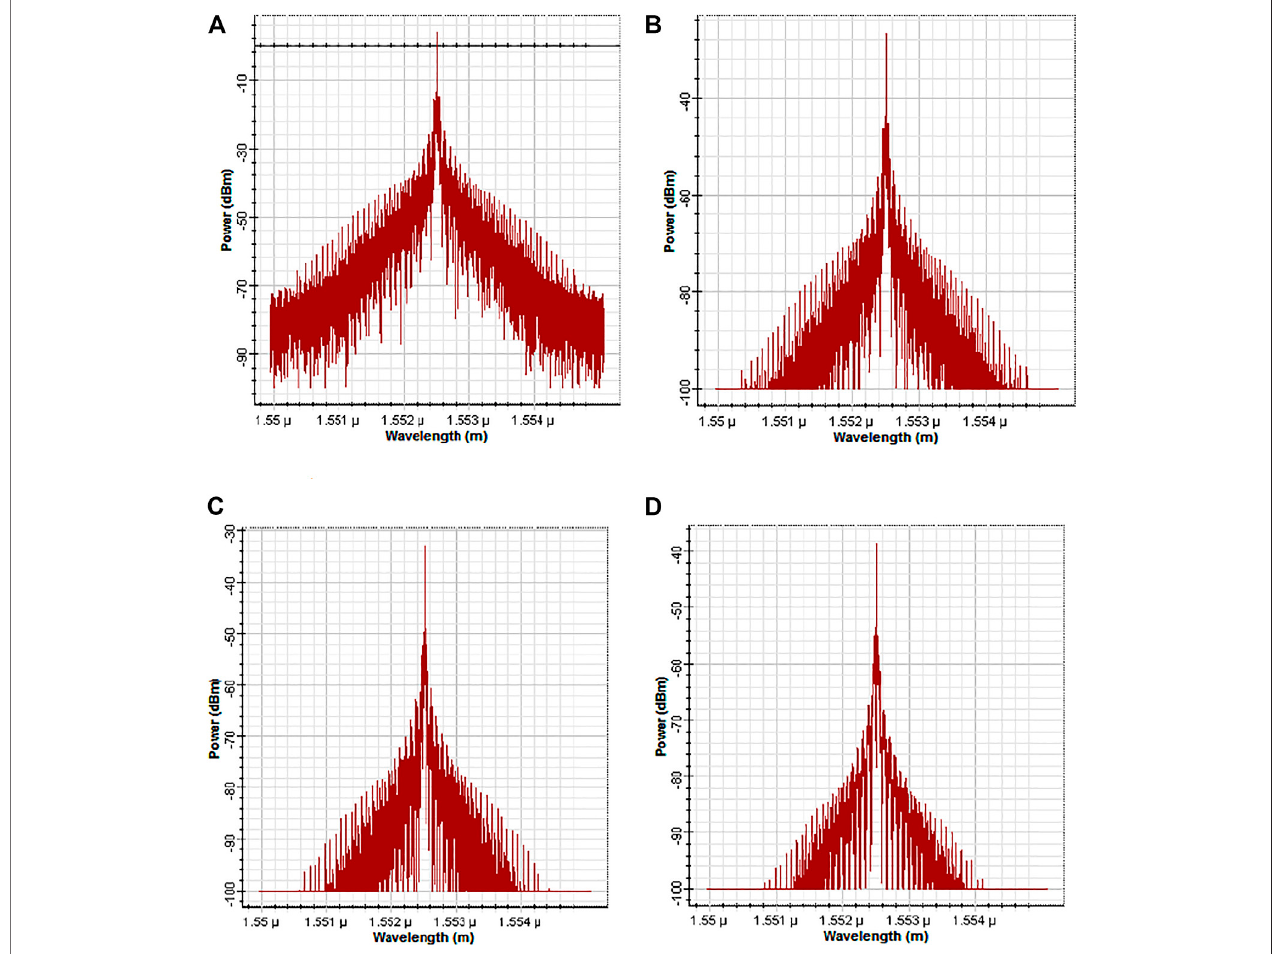
FIGURE 3 | Optical Spectrum of designed FSO system: (A) at the transmitter (B) at the receiver (beam divergence of 2 mrad) (C) at the receiver (beam divergence of 4 mrad) (D) at the receiver (beam divergence of 6 mrad).